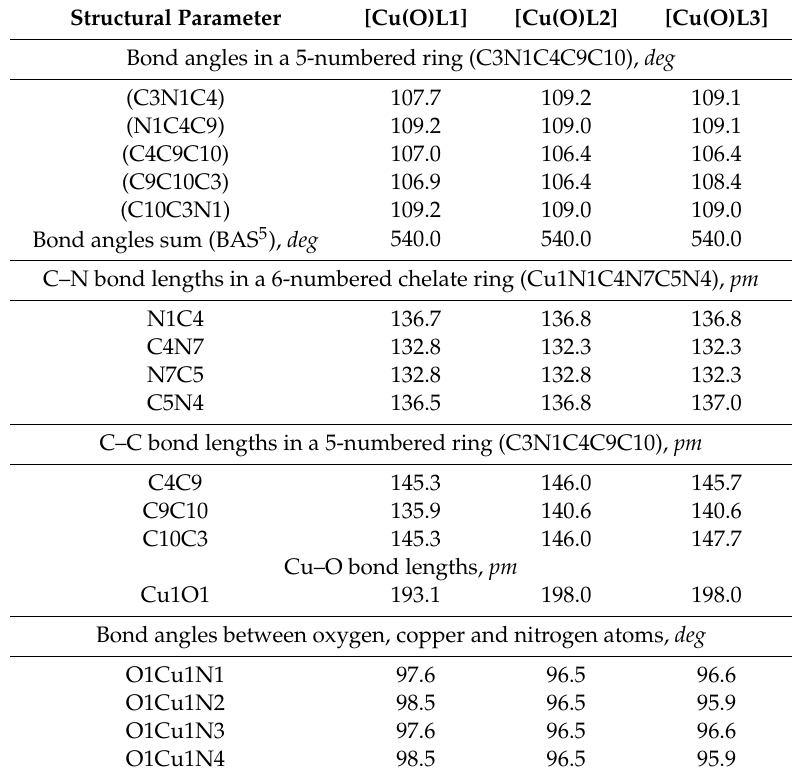
Structural Parameter